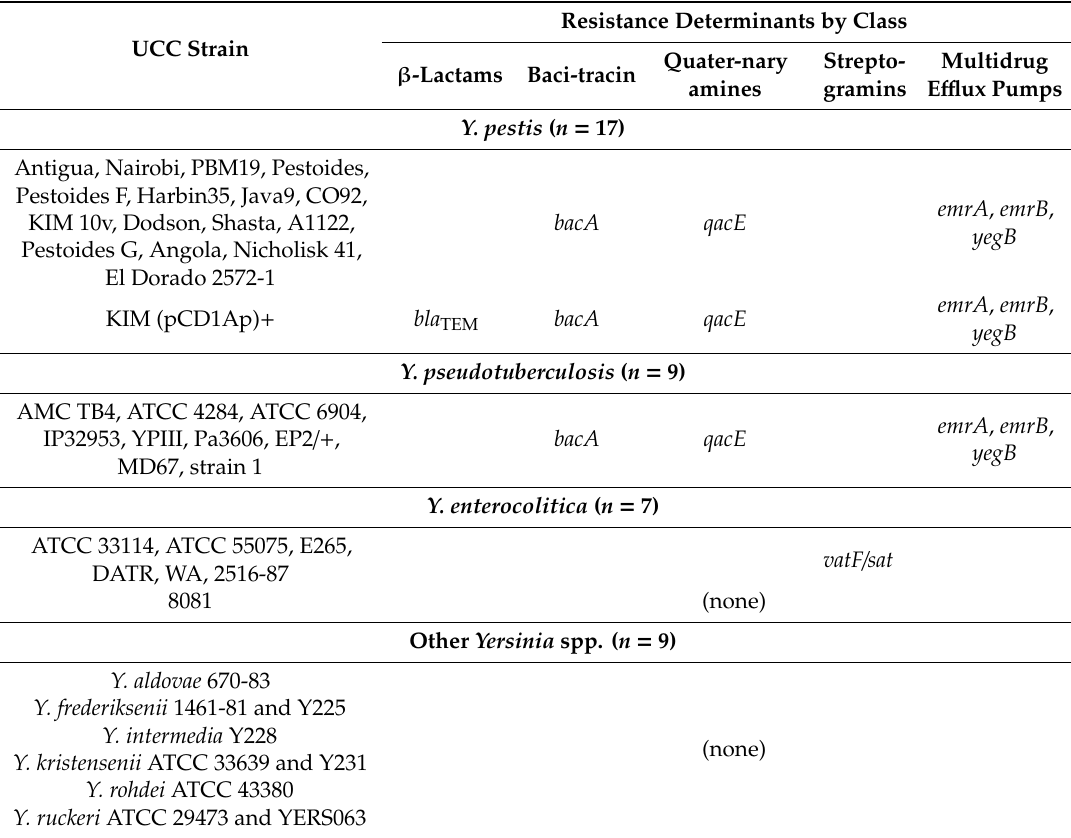
Table 3. Microarray-detected AMR genes in Yersinia spp. strains.